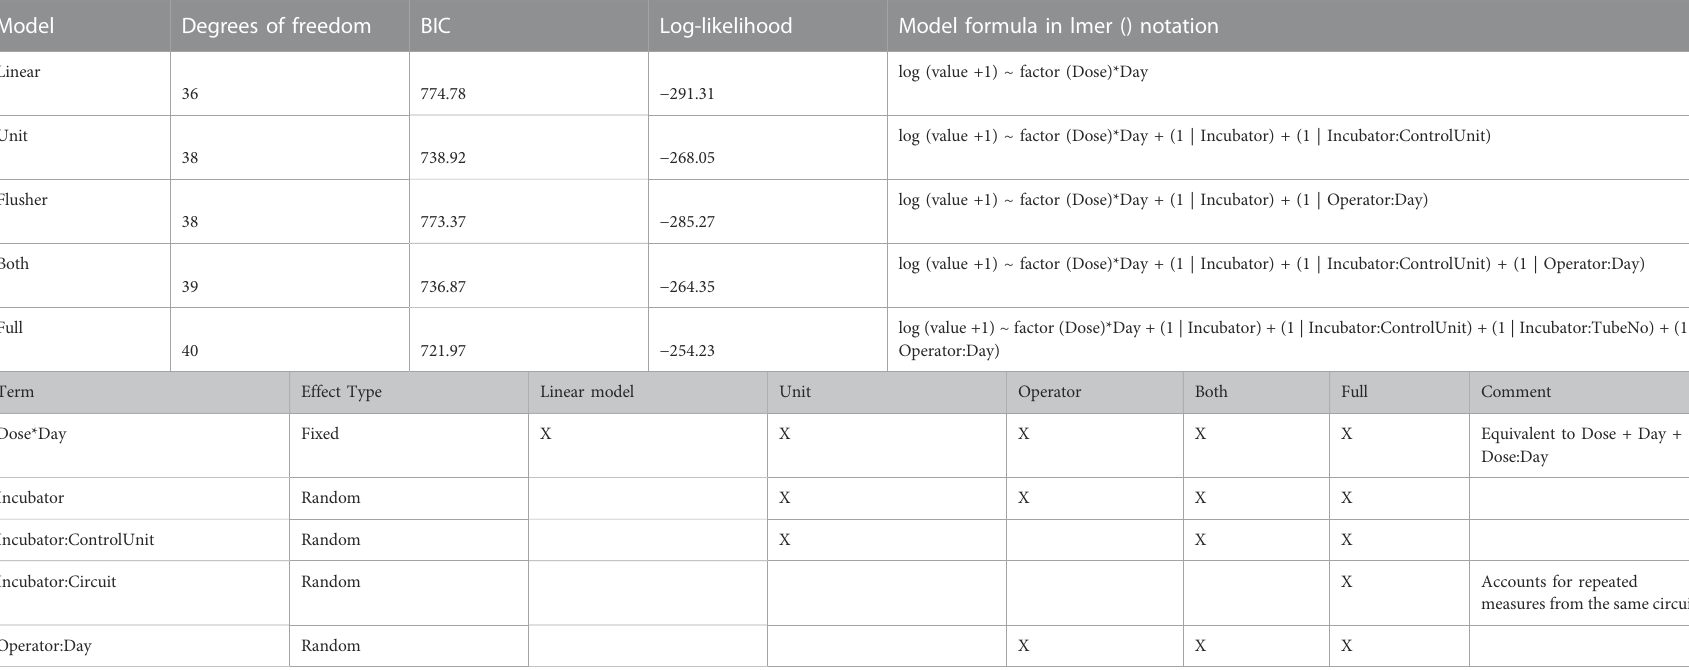
TABLE 3 Models used, with measures of fi t and terms